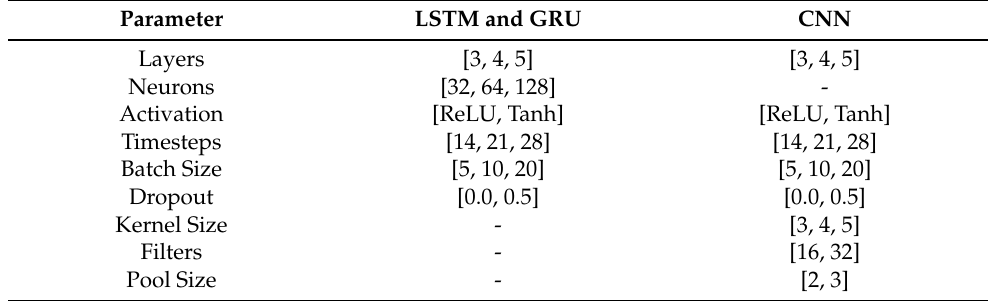
Table 6. Hyperparameters searching space.